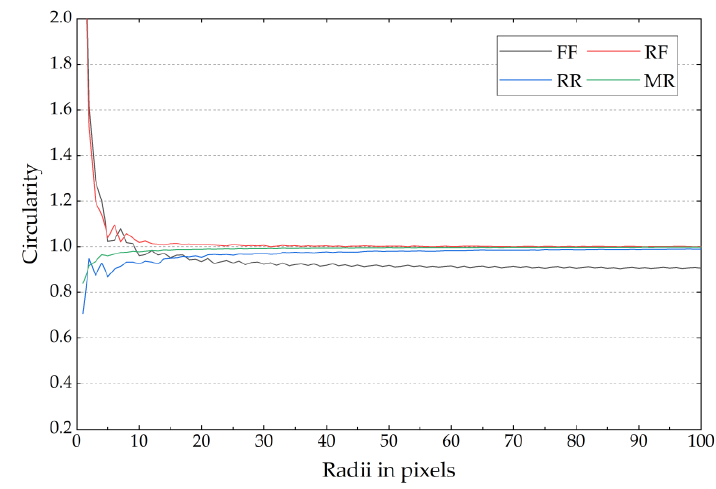
Figure 14. Circularities of perfect circles with varying radii.